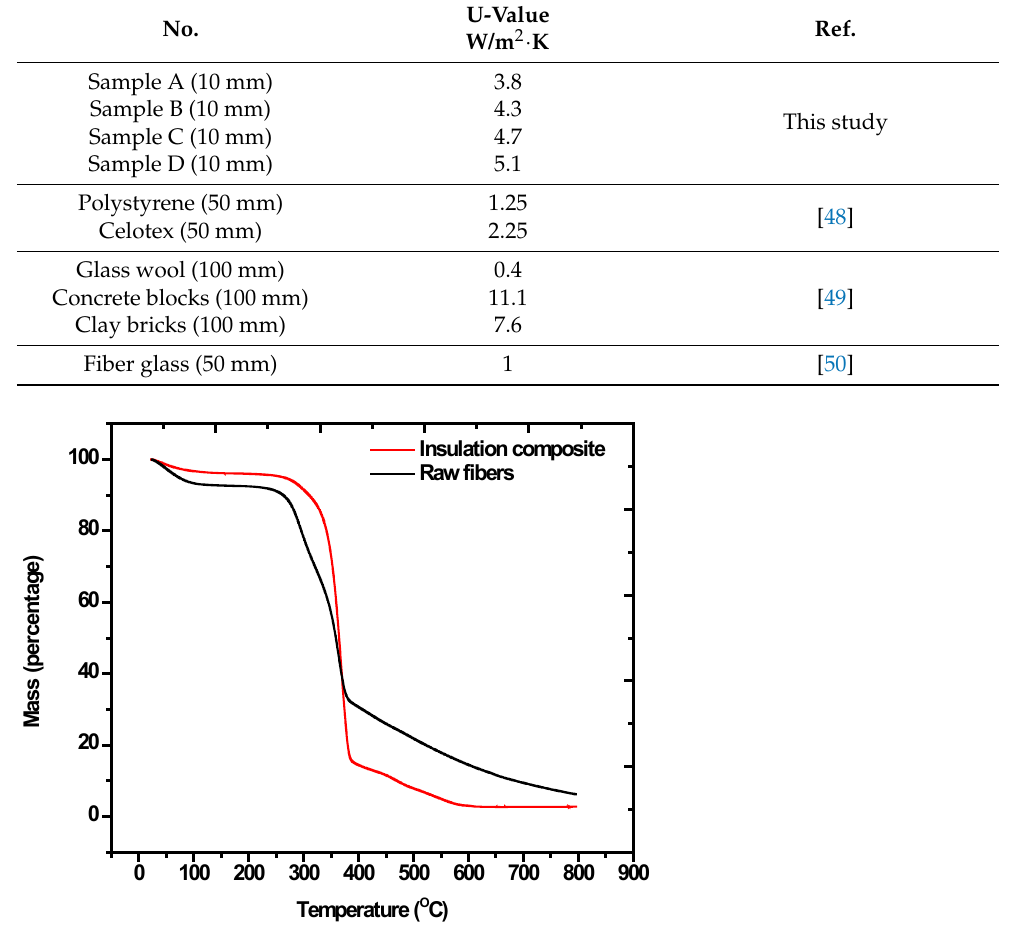
Figure 9. TGA analysis of raw fibers and the insulation composite. Table 5. Thermal characteristics of raw fibers and insulation